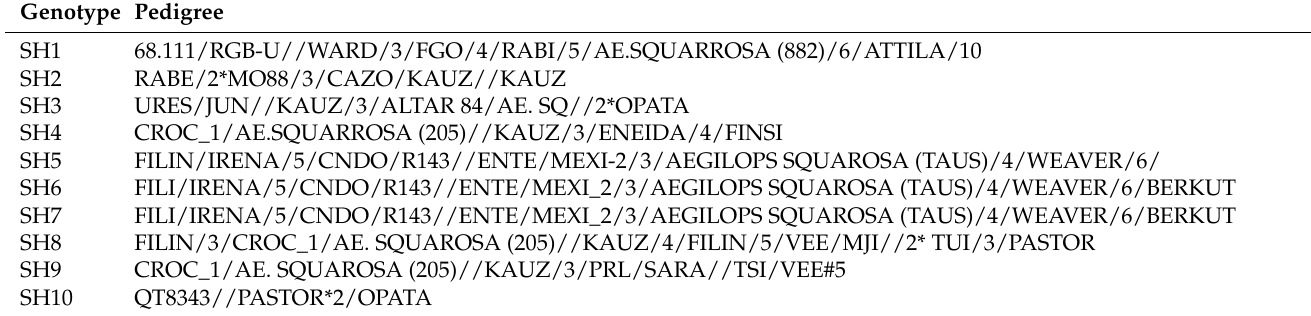
Table 1. List of synthetic hexaploid genotypes characterized for physiological, biochemical, and morphological traits under separate and combined regimes of in field drought and heat stress.